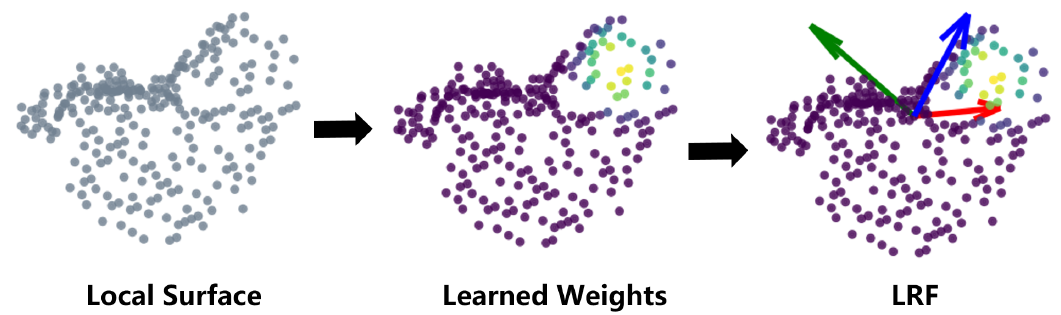
Figure 1. Local reference frame (LRF)-Net first assigns learned weights to points in a local surface and then uses these weights to estimate a repeatable and robust